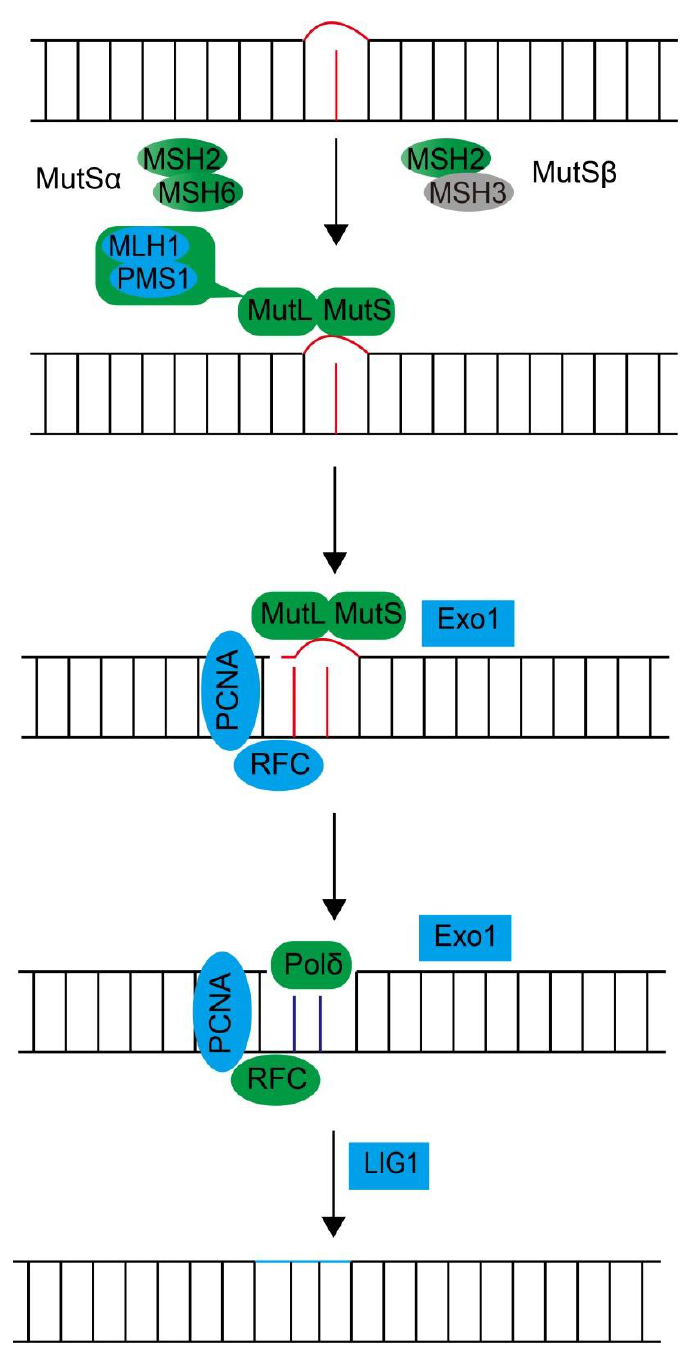
Figure 5. Diagrammatic summary of the dinoflagellate orthologues predicted in the DNA mismatch repair pathway. The rectangles and ellipses filled with grey color indicate the absence of putative dinoflagellate orthologues in the searched transcriptomes. The other colors in rectangles and ellipses indicate the presence of putative dinoflagellate orthologues.